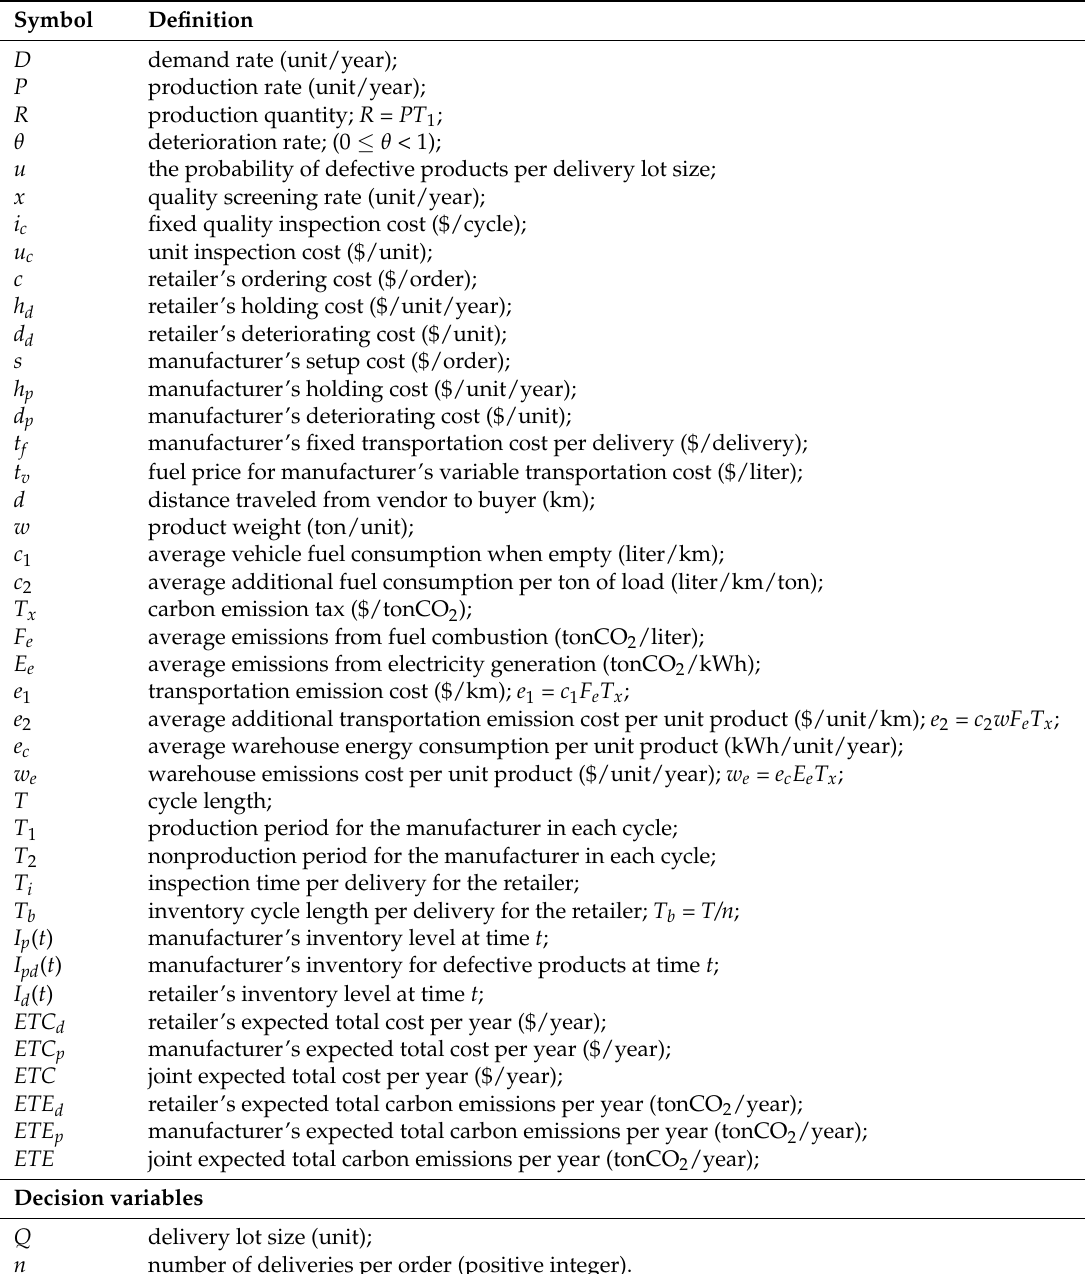
Table 2. List of